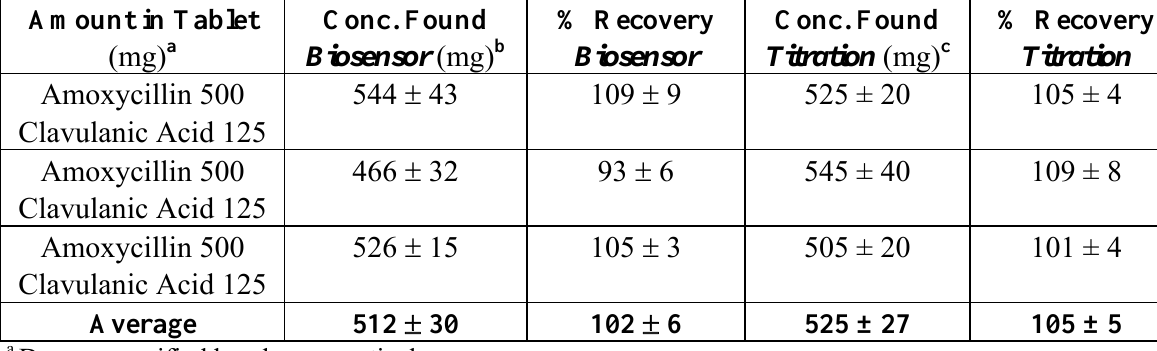
Table 2. Comparison of the Recoveries of Penicillin in Amoxycillin Tablets by PTy- PNCnase Biosensor and Titrimetric Method.